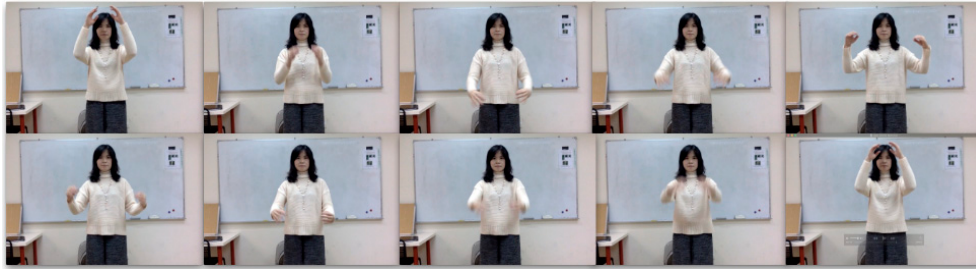
Figure 11. Two examples of a duple (2/4) gesture.